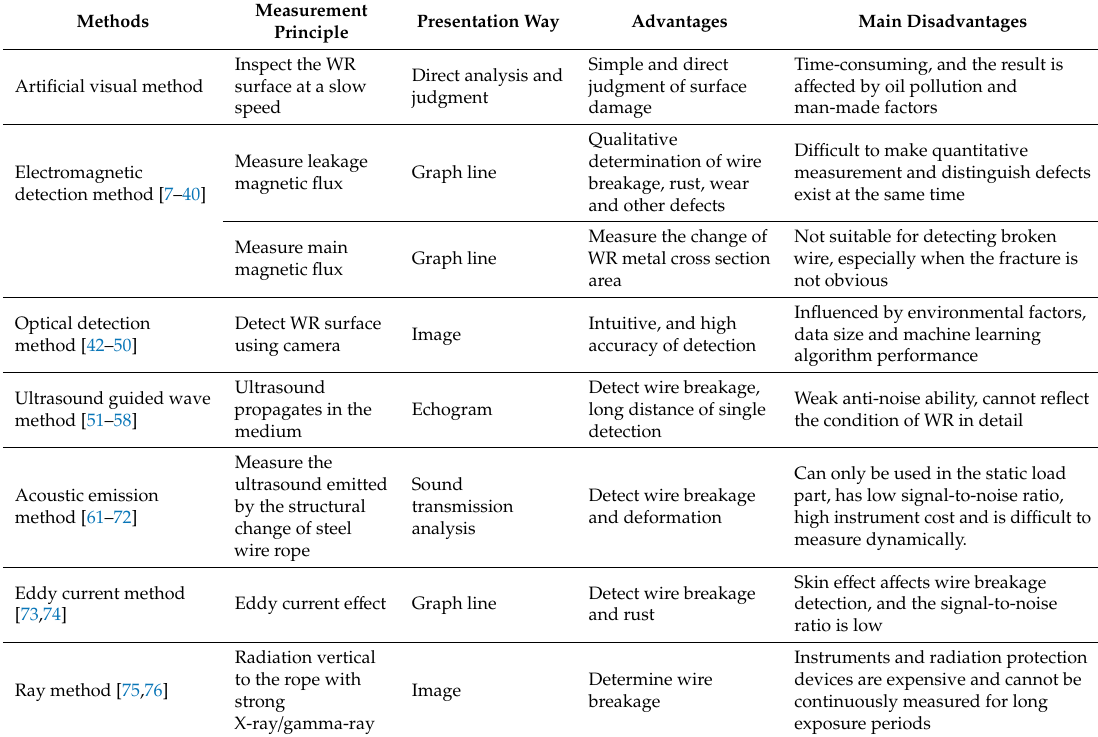
Table 2. Comparison of several wire rope detection